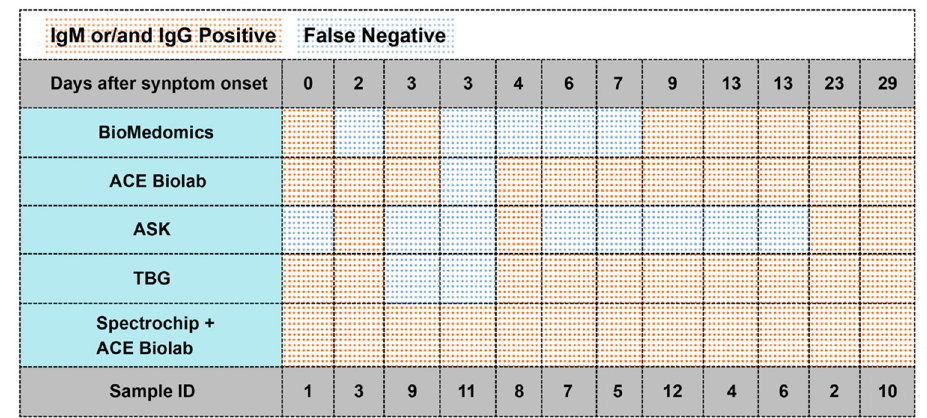
Fig 5. The performance of five types of lateral flow immunoassays. Samples of 12 RT-PCR positive subjects were followed up by days after symptoms onset. Abbreviations: BioMedomics, COVID-19 IgM/IgG Rapid Test (BIOMEDOMICS INC.); ACE Biolabs, COVID-19 IgG / IgM Dual Detection Kit (ACE Biolabs INC.); ASK, COVID- 19 Antibody Rapid Teat (TONYAR BIOTECH INC.); TBG, SARS-CoV-2 IgG/IgM Rapid Test Kit (TBG Diagnostics